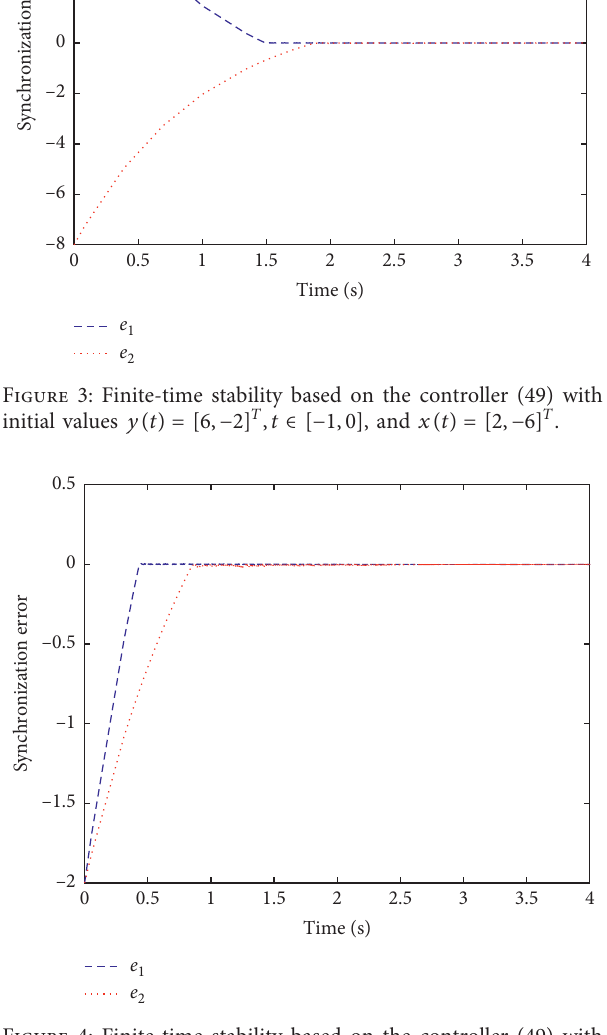
Figure 4: Finite-time stability based on the controller (49)